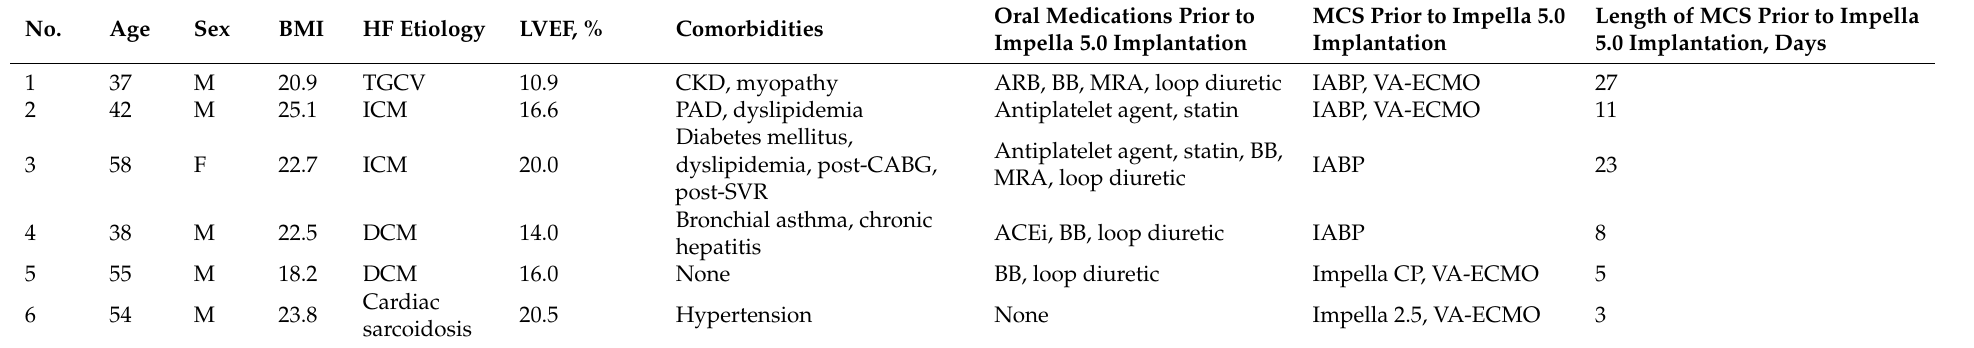
Table 1. Patient demographics, clinical characteristics, and interventions.